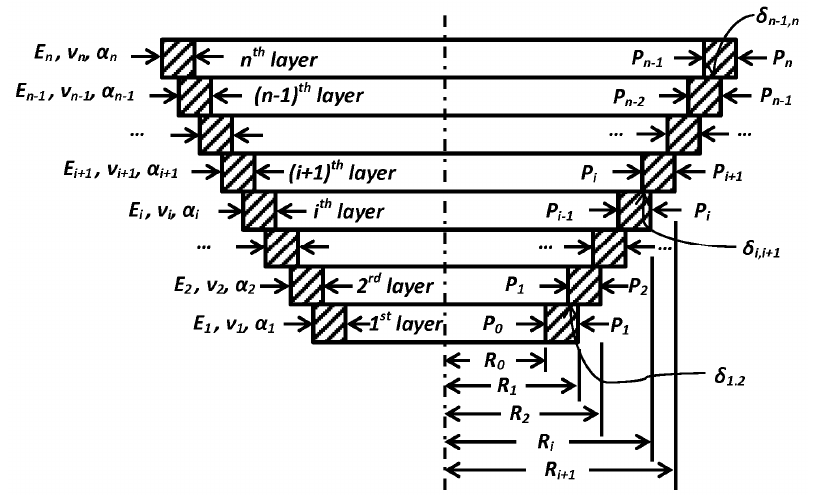
Figure 8. Sketch of interference fit of MLTWC.